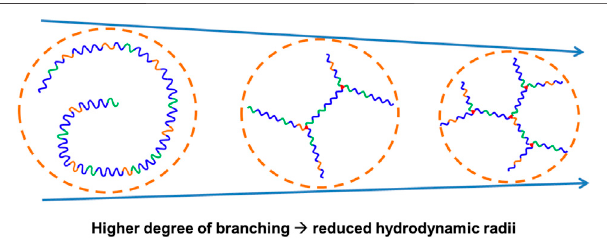
TABLE 2 | Summary of critical micelle concentrations (CMC), thermodynamic quantities of micellization, and micelle sizes of EPCG copolymers. Sample